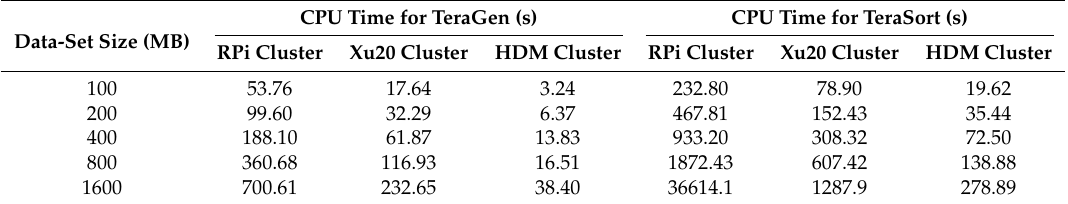
Table 8. Average CPU execution times for TeraSort and TeraGen benchmarks on the